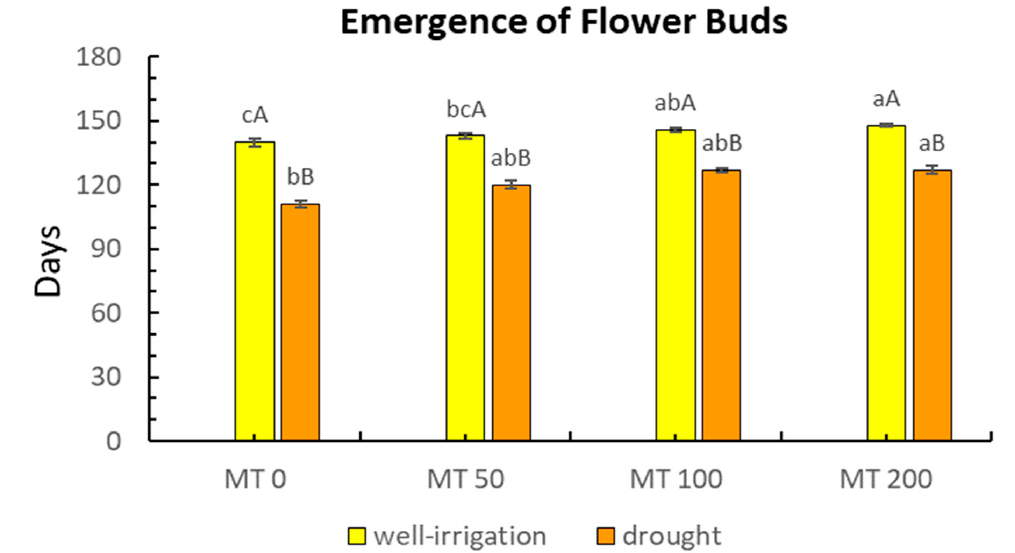
Figure 2. Effect of exogenous melatonin on the emergence of flower buds in R. asiaticus plants cultivated under well-irrigated and drought stress conditions. MT0, well-watered and drought-stressed plants without MT treatment; MT50, MT100, and MT200, treatment with MT at different concentrations (50, 100, and 200 μ M, respectively) under well-irrigated and drought circumstances. Lowercase letters: comparison of MT concentrations under fixed irrigation treatments; uppercase